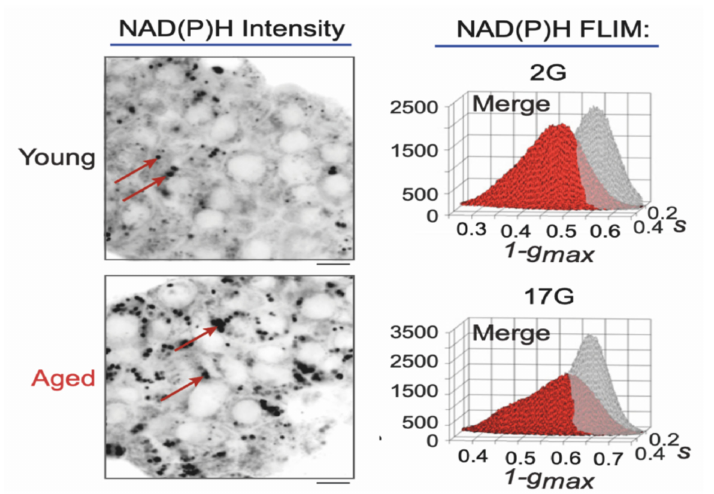
Figure 3. Phasor-FLIM analysis on human islets. Multiphoton FLIM of NAD(P)H in human islets from representative young (24 years old donor) and aged (58 years old donor) human donors. Phasor histograms show the frequency distribution of NAD(P)H lifetimes in young (black) and aged (red) islets. Scale bar = 5 µ m. 2G, 2mM glucose. 17G, 17mM glucose. Adapted from Gregg et al.